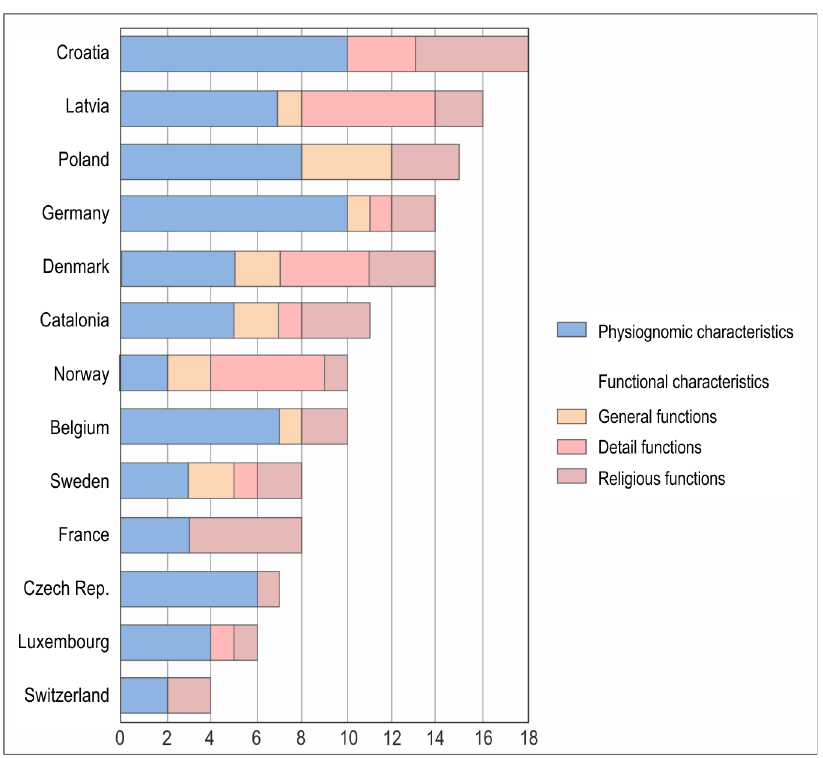
Fig. 4. The number of characteristics of buildings, structures and build-up areas on 1:100,000 maps, divided into different